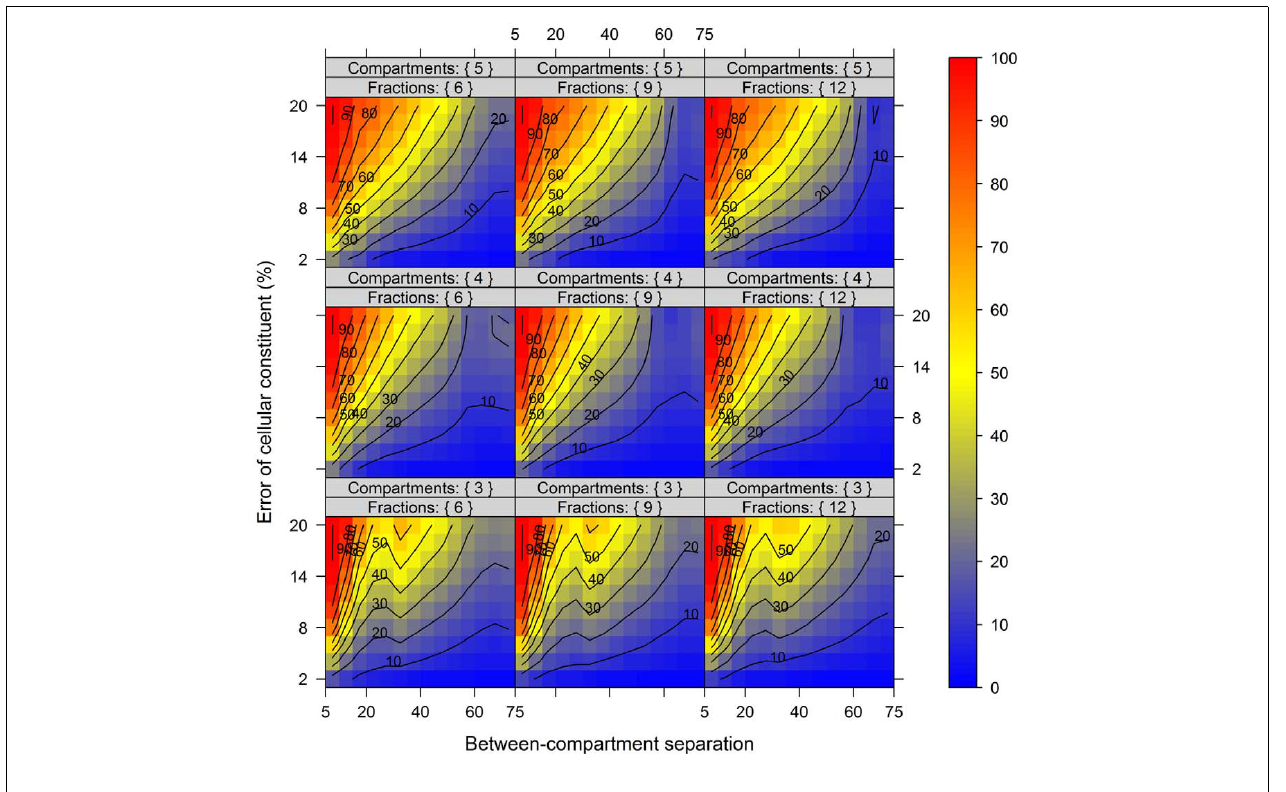
in dependence of the number of compartments (3–5) and number of fraction (6, 9, and 12) considered.The closer the value is to 0% the smaller the error of the compartmental abundances (estimated using NNLS), color-coded as depicted in the right-side bar. Contour lines are drawn for each 10%